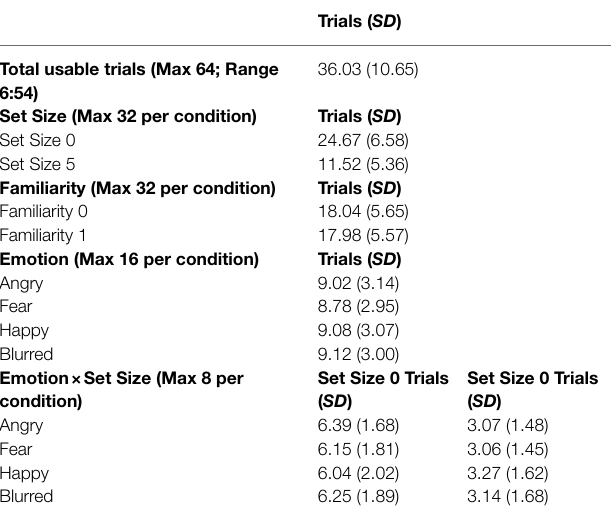
TABLE 1 | Mean usable trials across conditions.